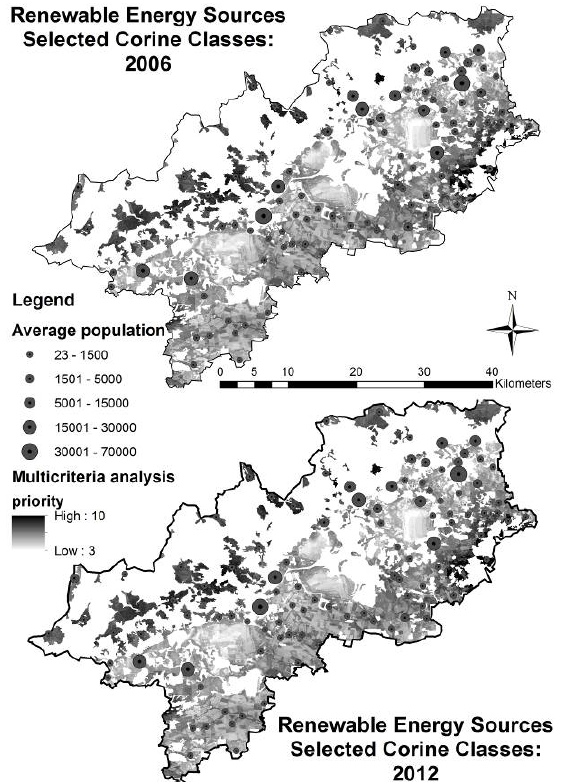
Figure 9. Moderate changes in mapping of suitable sites for utilization of renewable energy sources in 2006 and